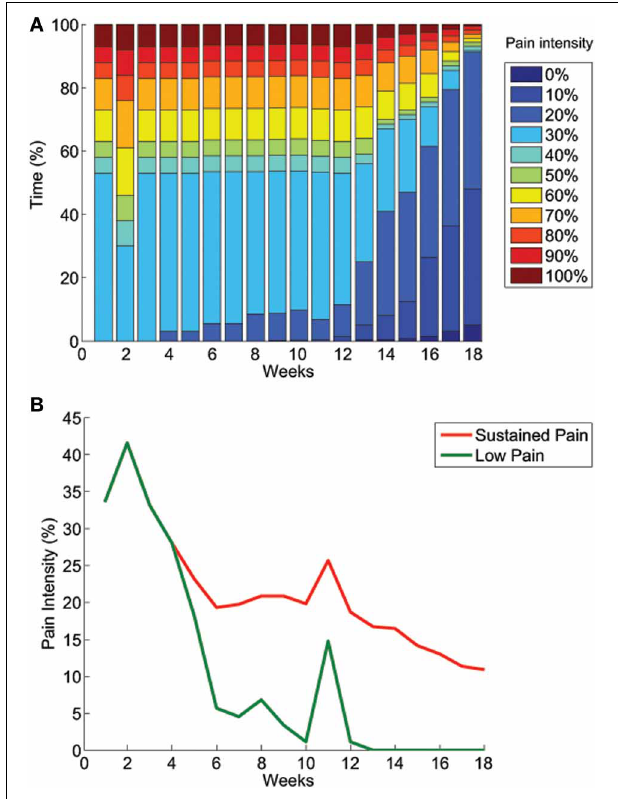
FIGURE 2 | Evolution of pain intensity over time. (A) The distribution of pain intensity over time shows that at the beginning of the treatment, the patient had a sustained level of pain ( ∼ 30%) during more than half of the time, and periods with higher levels of pain the rest of the time. Over the course of the treatment, a reduction of time at higher pain intensity levels was reported, as well as the appearance of periods of lower or absent pain. (B) The sustained level of pain was also the lowest pain perceived by the patient, and it gradually decreased to around 10% over the course of the interventions. Episodes of reduced pain started occurring after 4 weeks of treatment and gradually became pain-free periods. In week 11, a problem with his socket prosthesis caused him to use an old, tighter socket that had previously been shown to induce pain.